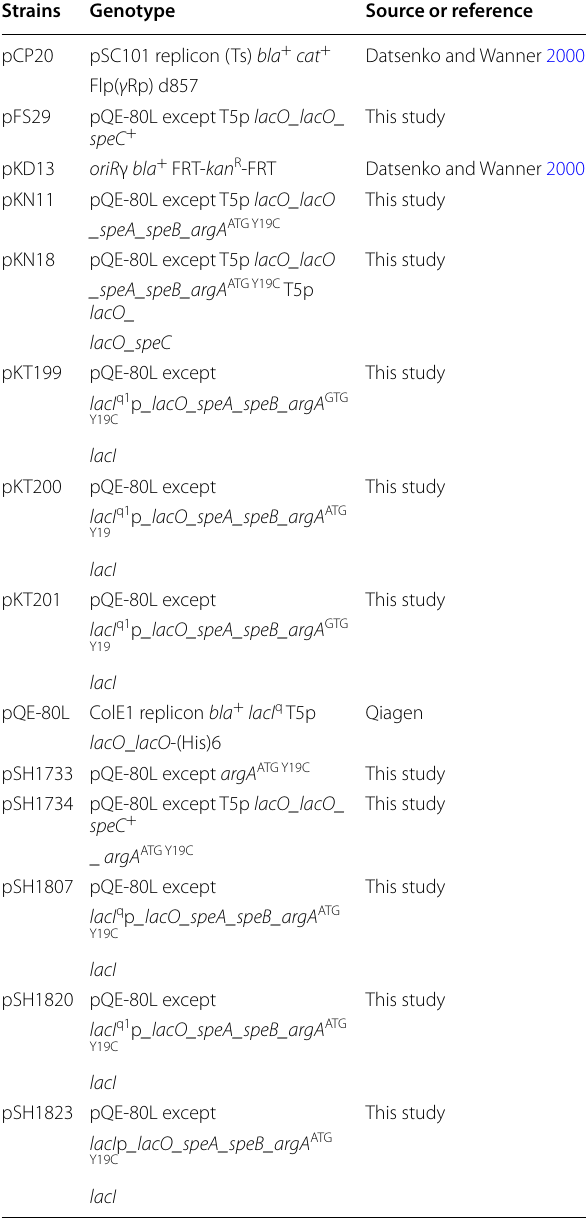
Table 2 Plasmids used in this